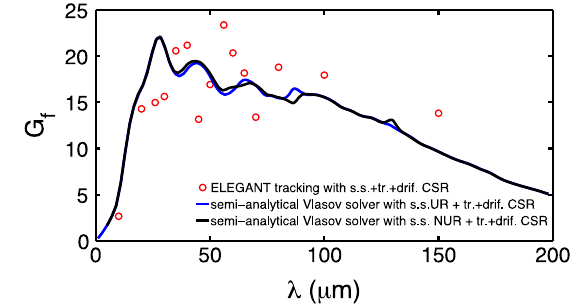
FIG. 9. Microbunching gain spectra with all relevant CSR effects. ELEGANT results include both entrance and exit transient as well as steady-state impedances. The initial modulation amplitudes are varied around 0.1% – 0.6% to ensure numerical convergence.